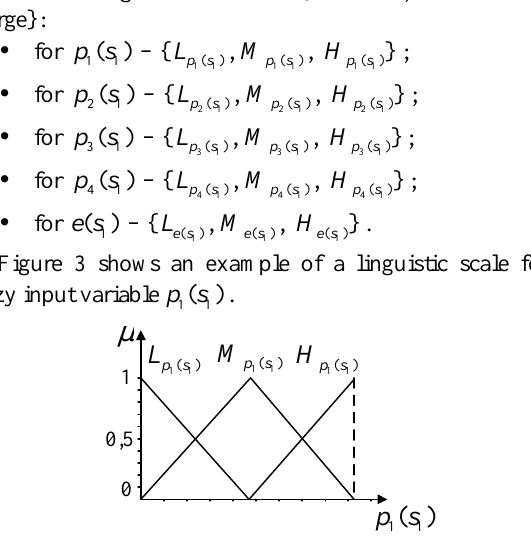
Figure 3. An example of a linguistic scale for input fuzzy variable